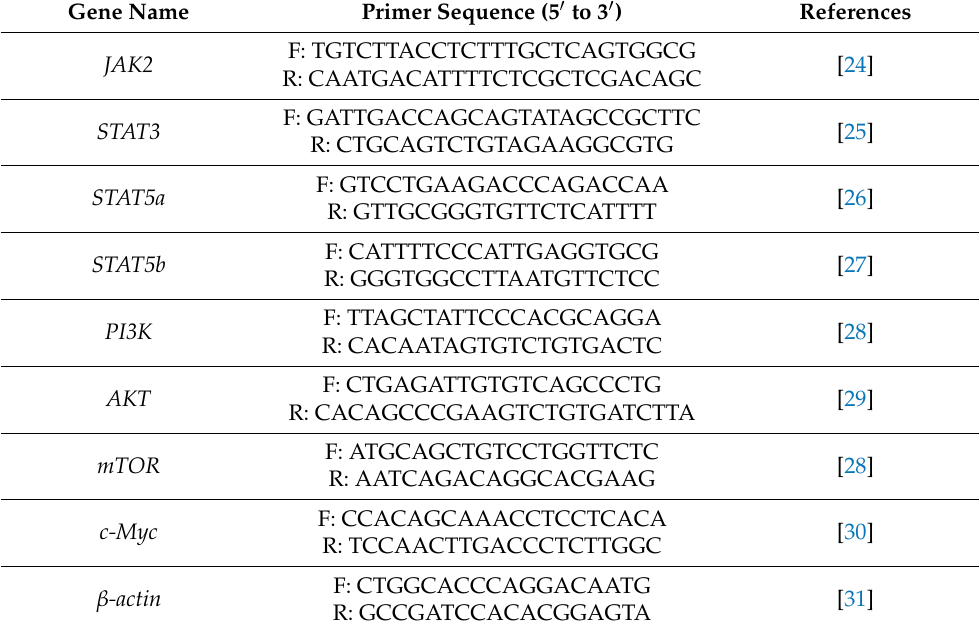
Table 1. Sequences of primers used to quantify gene expression by